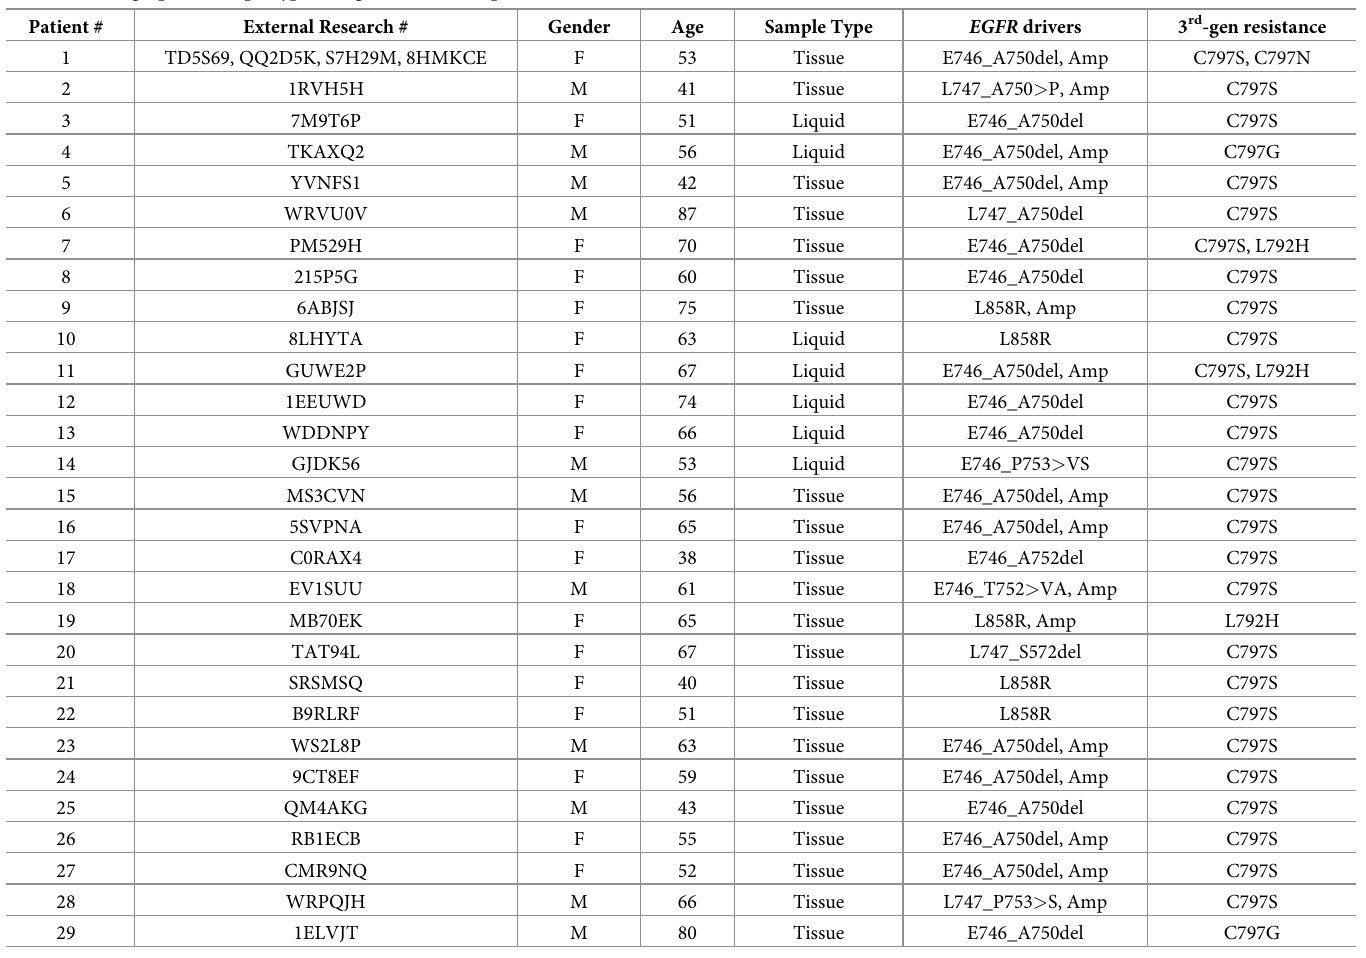
Table 2. Demographics, sample type, and genomic data of patient